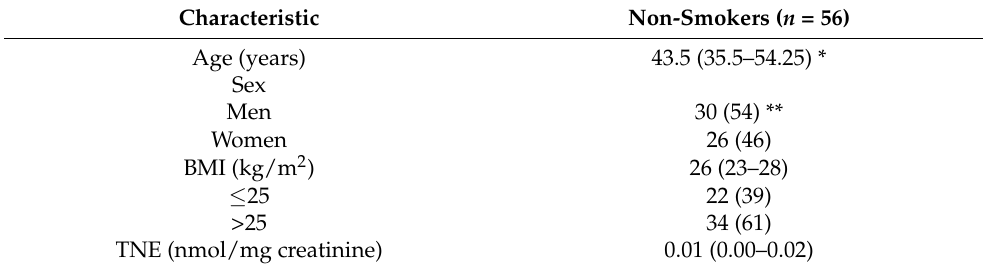
Table 2. Summary of participant demographics and verification of smoking